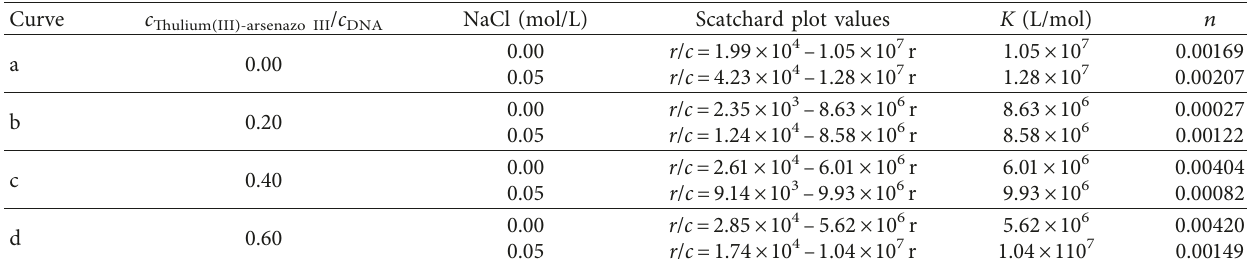
Figure 7: Scatchard plots of the interaction between thulium(III)-arsenazo III and DNA in different concentrations of AO. (a) Without 6 mol/L; c 6 mol/L; c 5 mol/L (10 μ L per can); 8.30 10 NaCl; (b) with NaCl (pH 7.40). c Thulium (III)-arsenazo III DNA (cid:31) 4.00 × 10 AO (cid:31) 4.00 × 10 (cid:31) × (cid:31) Rt c Thulium(III)-arsenazo III / c DNA ; a, Rt 0.00; b, Rt 0.20; c, Rt 0.40; d, Rt 0.60. − − − (cid:31) (cid:31) (cid:31) (cid:31) (cid:31) Table 1: Data from the Scatchard equation on the interaction between thulium(III)-arsenazo III complex and DNA. Curve c Thulium(III)-arsenazo III / c DNA